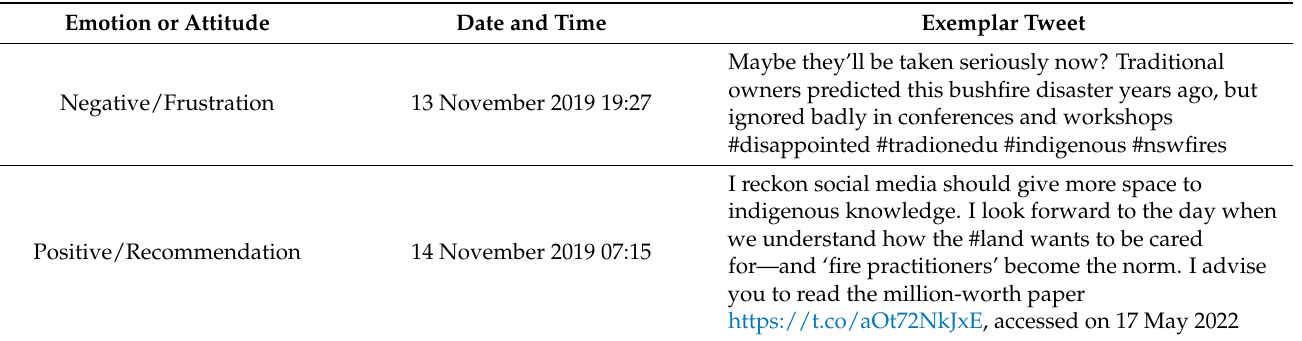
Table 6. Main attitudes expressed related to traditional disaster education